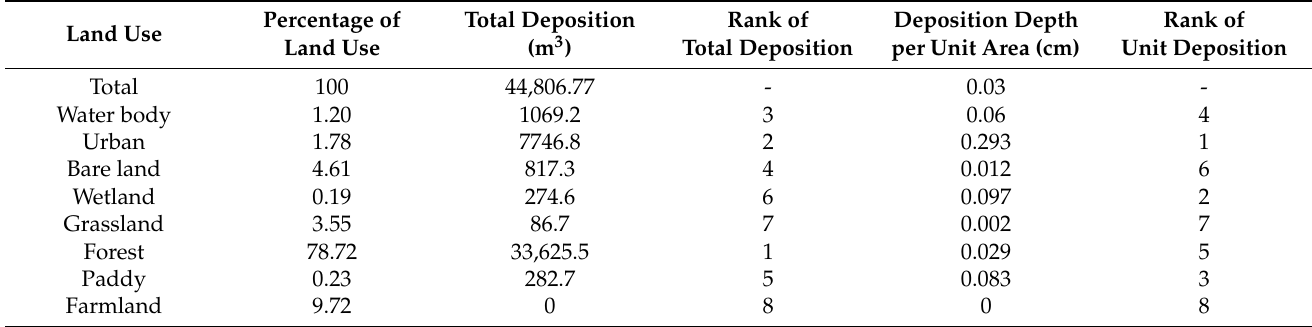
Table 11. Results of deposition for land use (the calibrated model, Typhoon